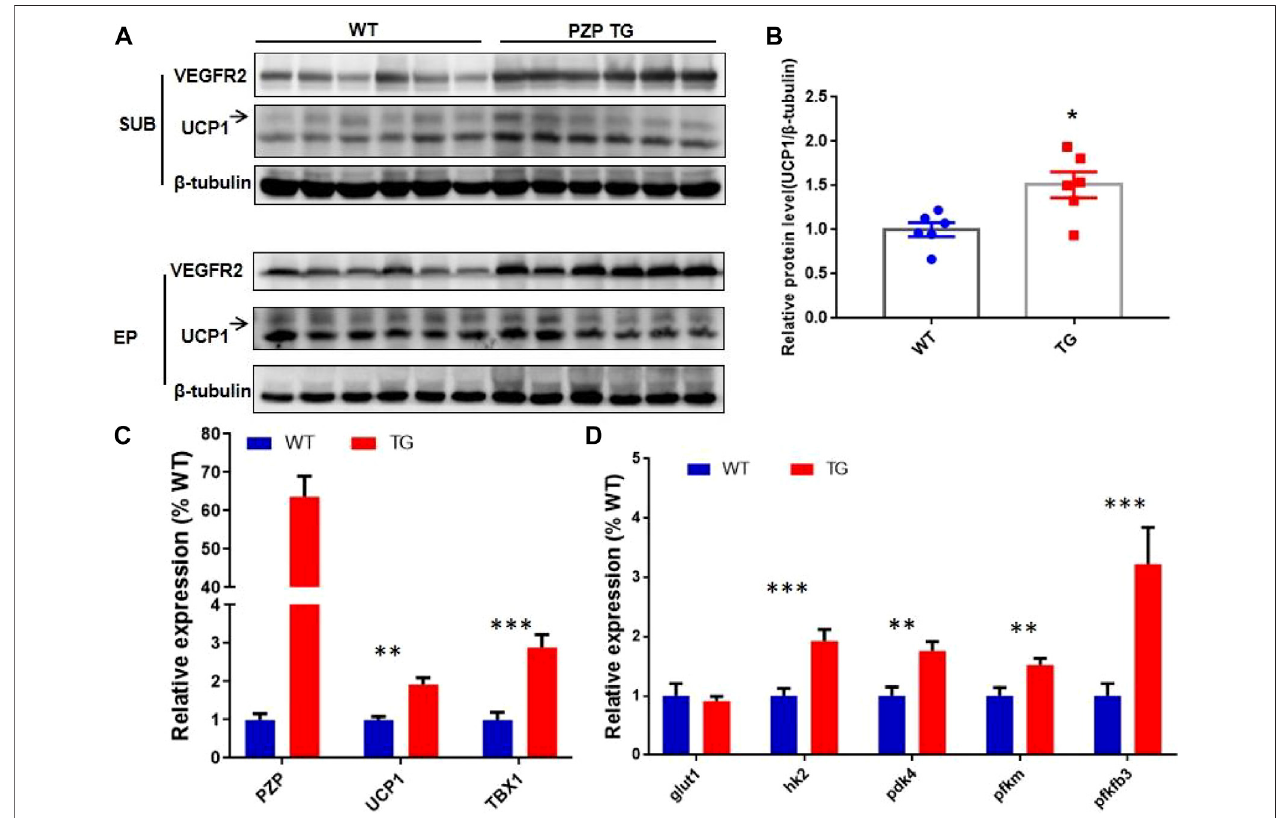
FIGURE 4 | PZP TG promotes WAT remodeling against HFD. (A) Immunoblots of total iWAT and vWAT lysates from WT and PZP TG mice using indicated antibodies. (B) UCP1 protein abundance of iWAT from TG mice was signi fi cantly higher than that from the WT mice. (C) Relative mRNA expression of the mentioned genes in SUB from WT and PZP TG mice ( n = 7). (D) Relative mRNA expression of glucose metabolism-related genes in iWAT from WT and PZP TG mice ( n = 7).